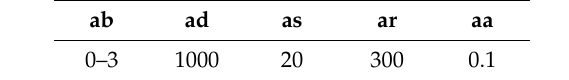
Table 3. Radiance parameters used in irradiation simulations.